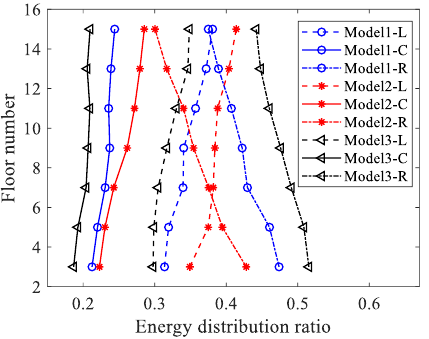
Figure 12. Energy distribution ratio.